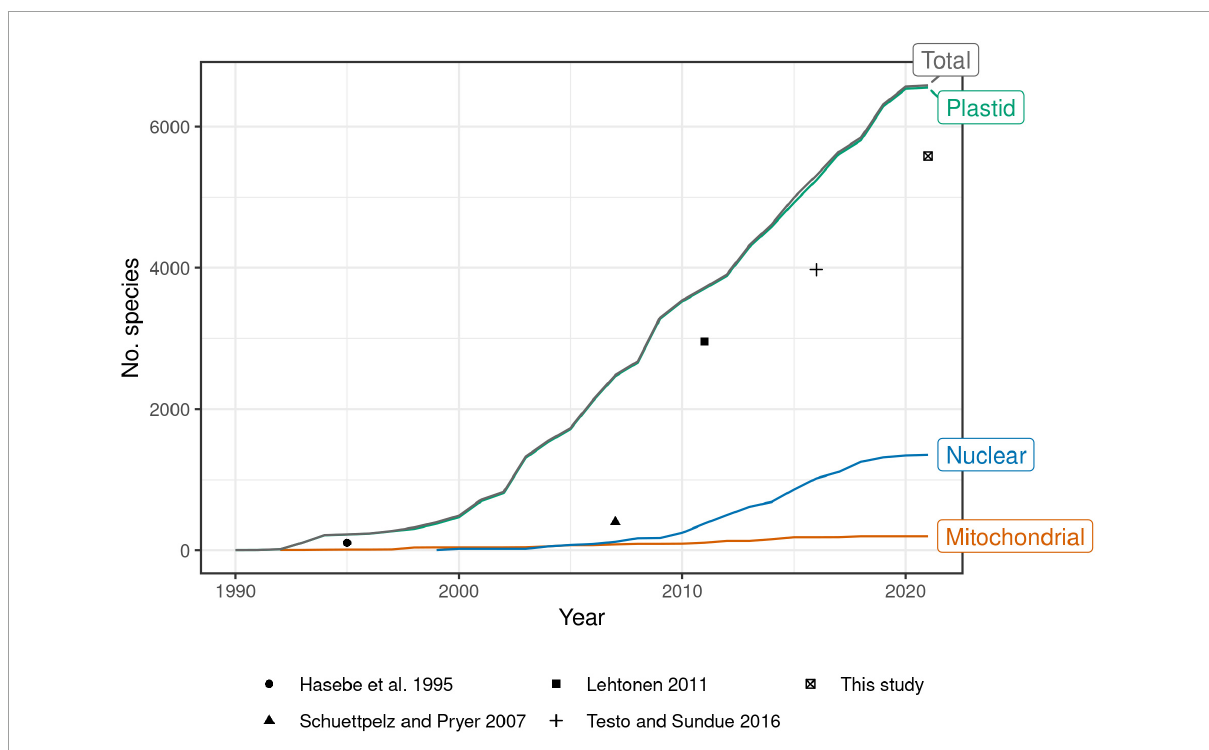
FIGURE1 Number of fern species in GenBank by year and genomic compartment, 1990–2021. Points indicate number of species sampled in selected studies of global fern phylogeny (Hasebe et al., 1995; Schuettpelz and Pryer, 2007; Lehtonen, 2011; Testo and Sundue, 2016; this study). This study plotted as 2021 but includes data until 2022-04-15. Schuettpelz and Pryer (2007) did not attempt exhaustive sampling but rather proportional sampling according to lineage size. The relatively small increase in number of species in 2021 may be due to accessions that were still embargoed at the time of writing. Taxonomy of GenBank species follows NCBI (Federhen, 2012). Only accessions identified to species included; environmental samples, hybrid formulas, and names with “aff.” or “cf.” annotations